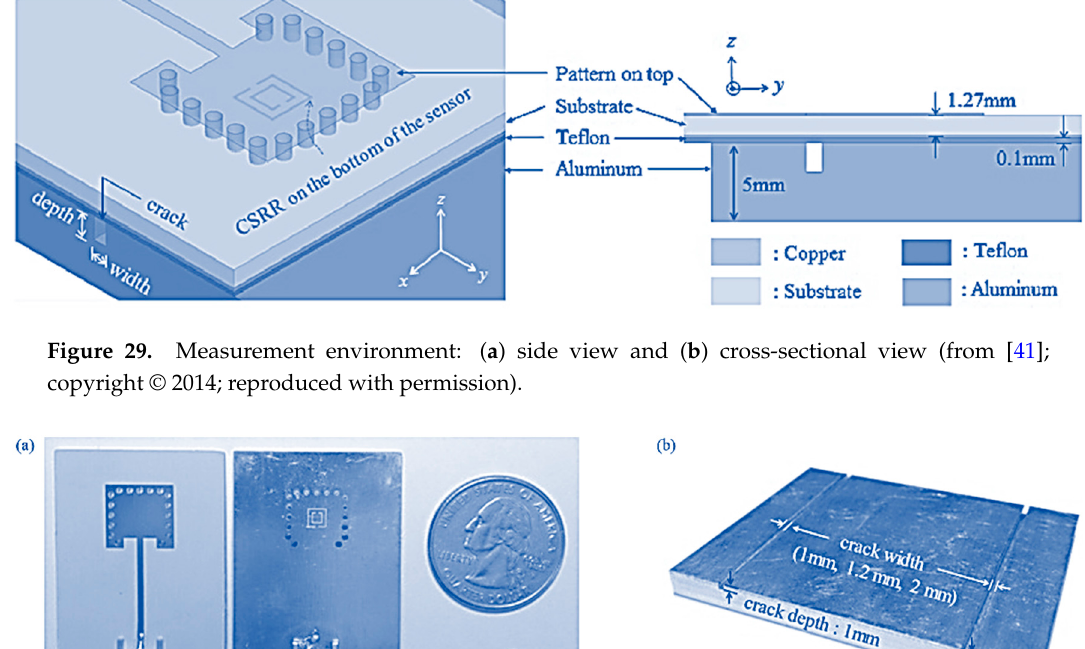
Figure 32. Simulated and measured results of the re fl ection coef fi cient for a crack depth of 2 mm (from [41]; copyright © 2014; reproduced with permission).